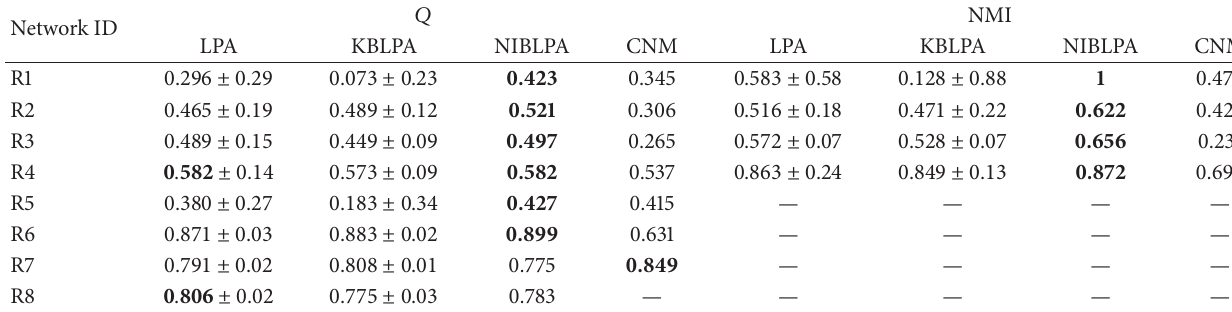
Table 6: The comparison of results on real